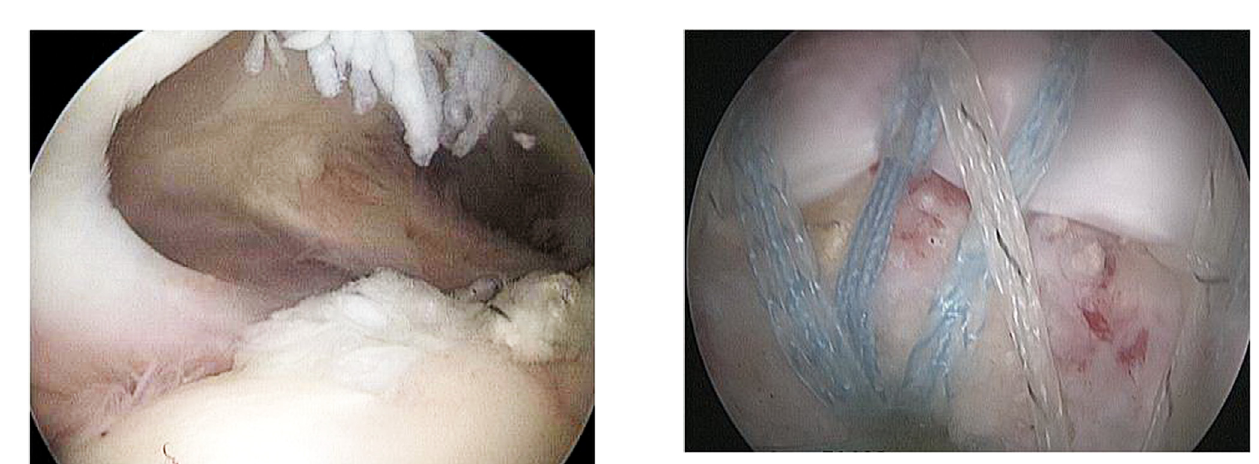
Figure 3. Arthroscopic transosseous-equivalent rotator cuff repair construct